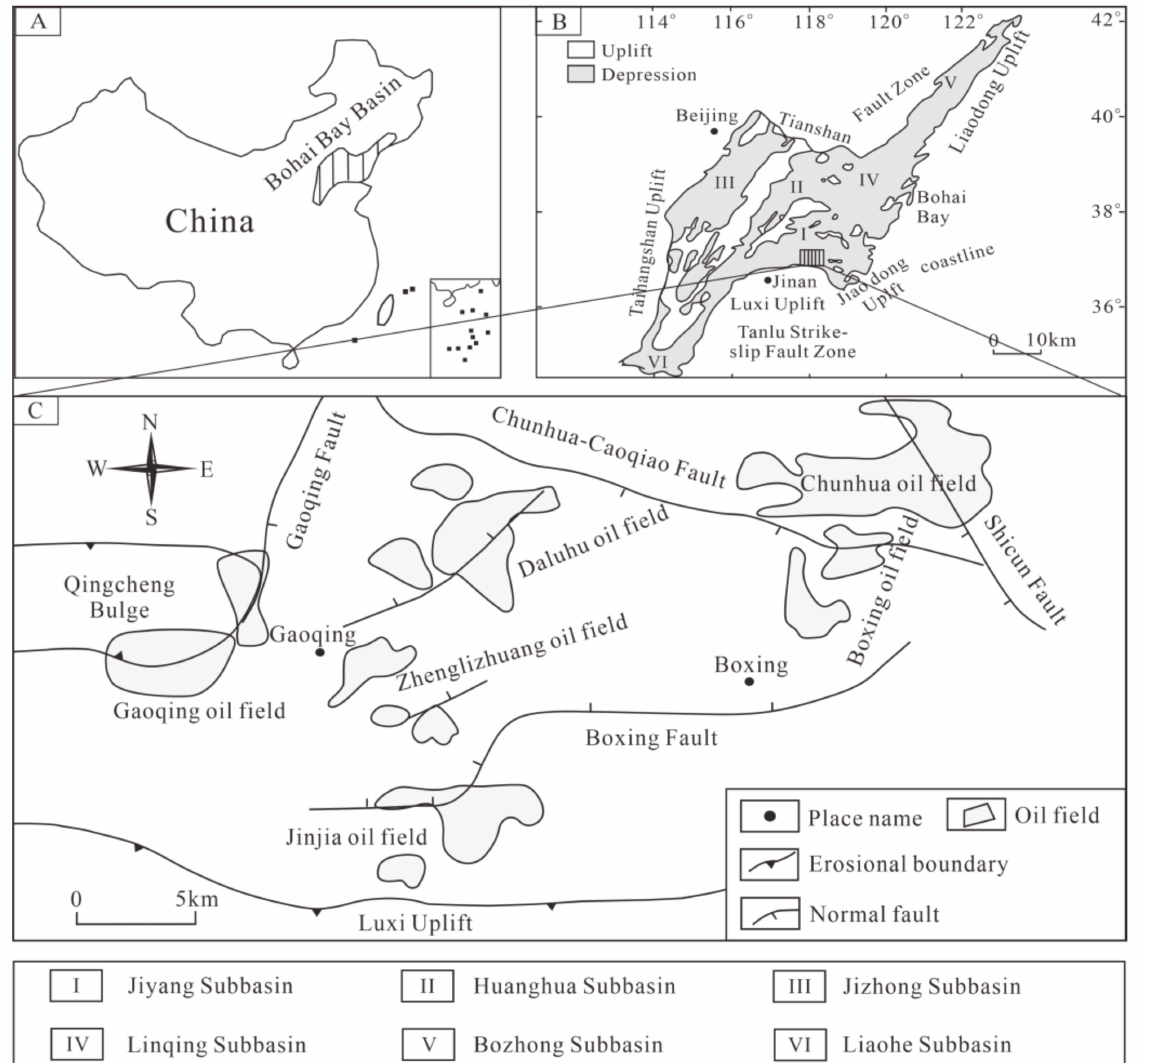
Figure 1. ( A – C ) Geological location of the study area in the Dongying Depression, Bohai Bay Basin,